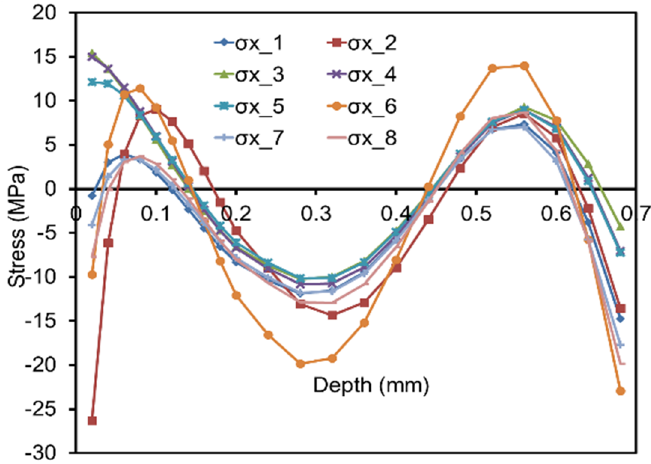
Figure 18. Resulting residual stresses with a large increment size of 80 μ m.